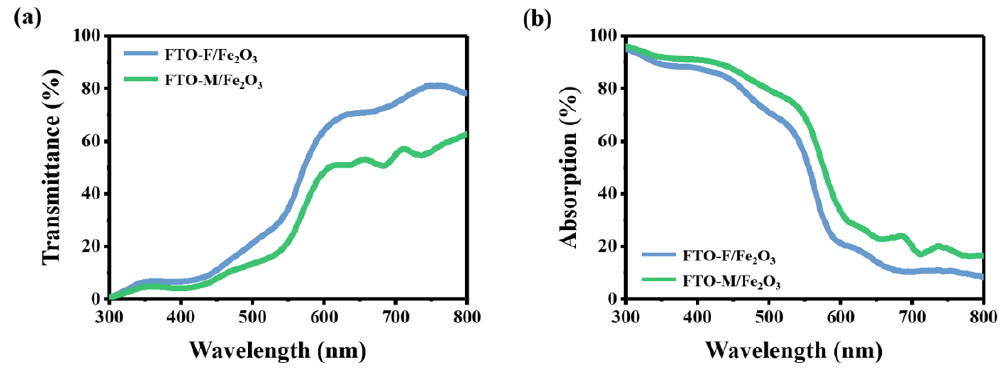
Figure 4. Optical properties of FTO-M/Fe 2 O 3 and FTO-F/Fe 2 O 3 : ( a ) Transmittance and ( b ) Absorp- tion.